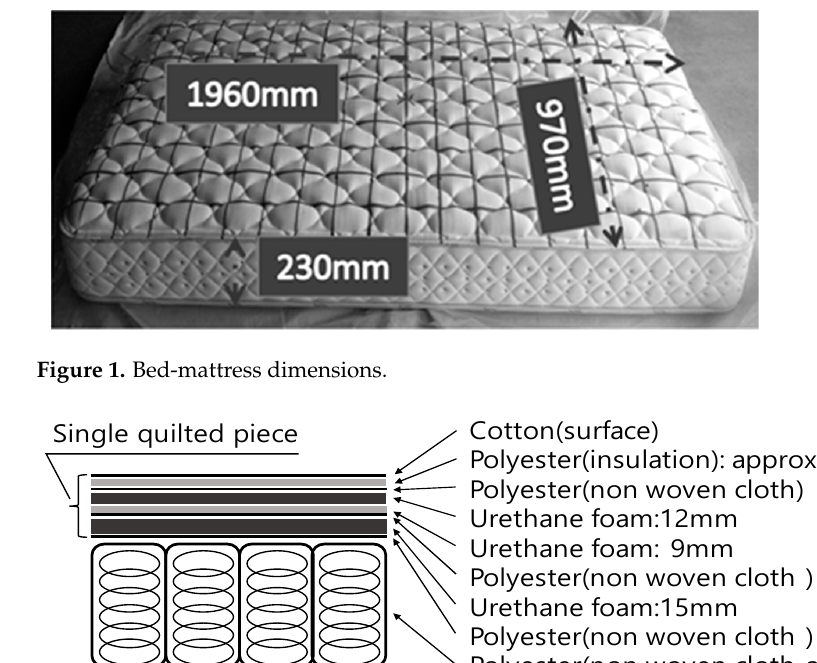
Figure 2. Mattress composition (single side).